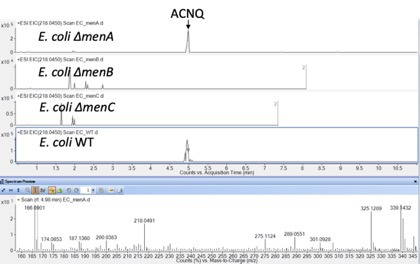
Production of ACNQ by various E. coli K12 men mutants.Production was only observed in the WT and ΔmenA mutant, consistent with the MR-1 data.